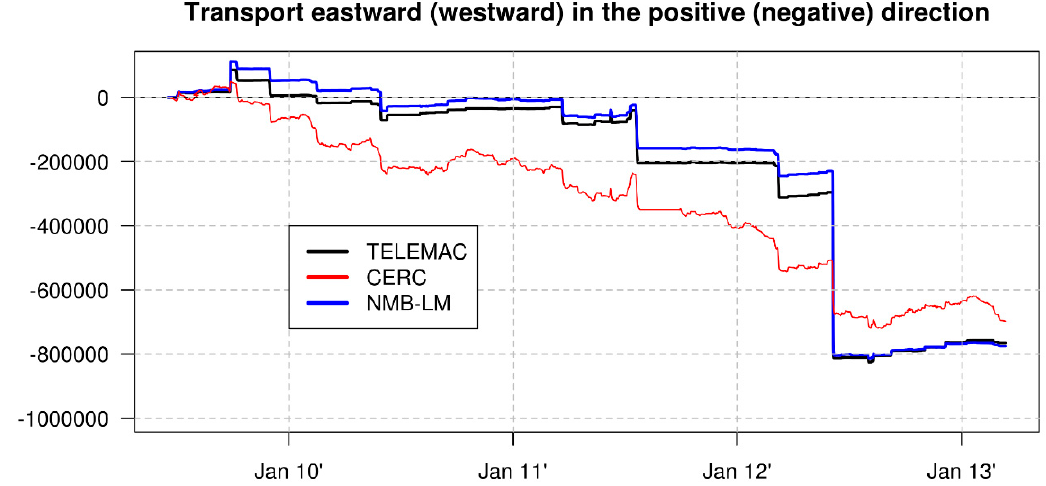
Figure 4. Model bed evolution validation in the location of the storm-bar and trough at both single- beam survey sites. Plotted are the model bed elevation median changes over the first nine simulations (10 surveys over 33 months). The dashed grey line is plus or minus one standard deviation of a linear fit to all data. The dashed black line is the one-to-one line.